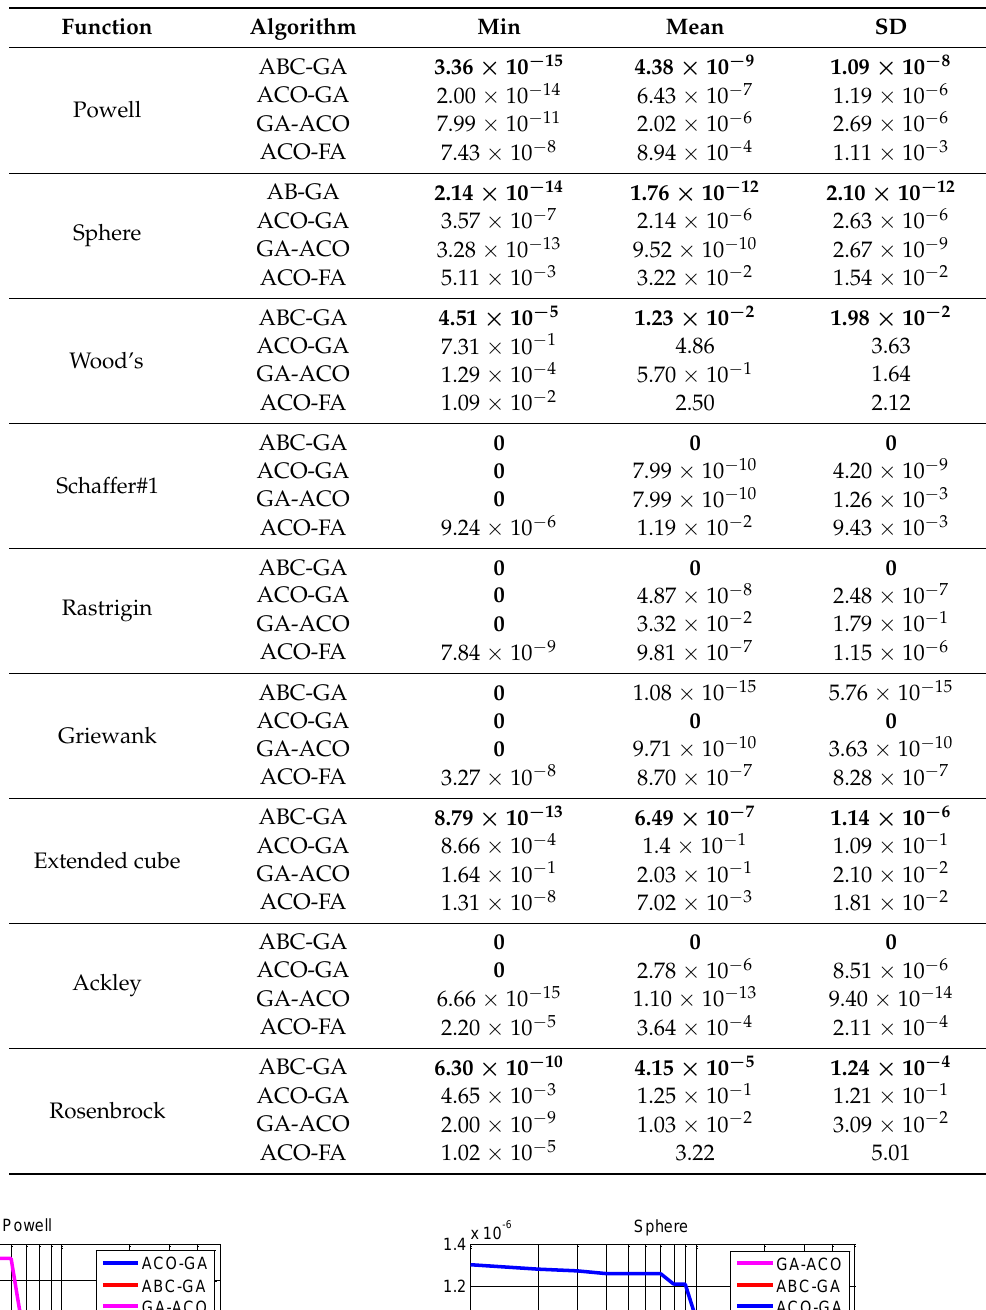
Table 3. Statistical results for the benchmark functions for different algorithms.